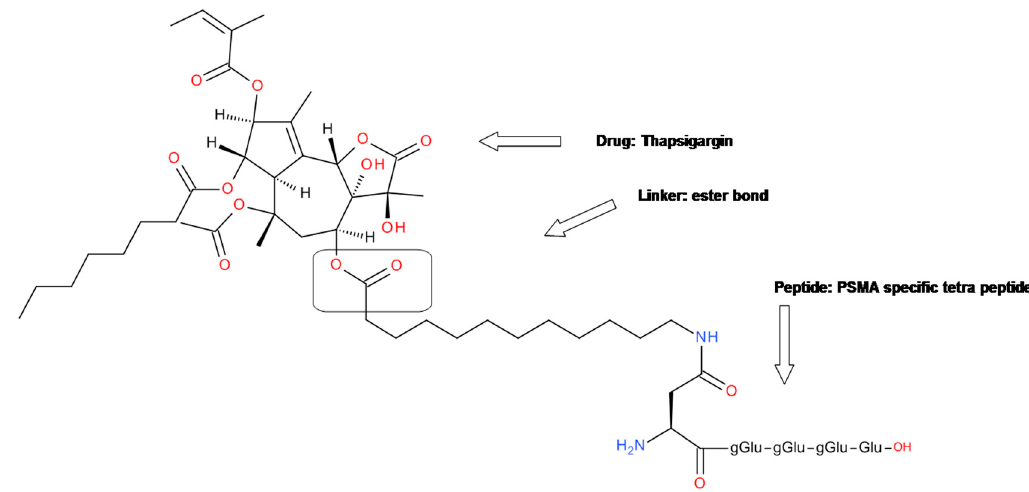
Figure 4. Chemical structure of tetrapeptide-thapsigargin conjugate G202 (Mipsagargin).